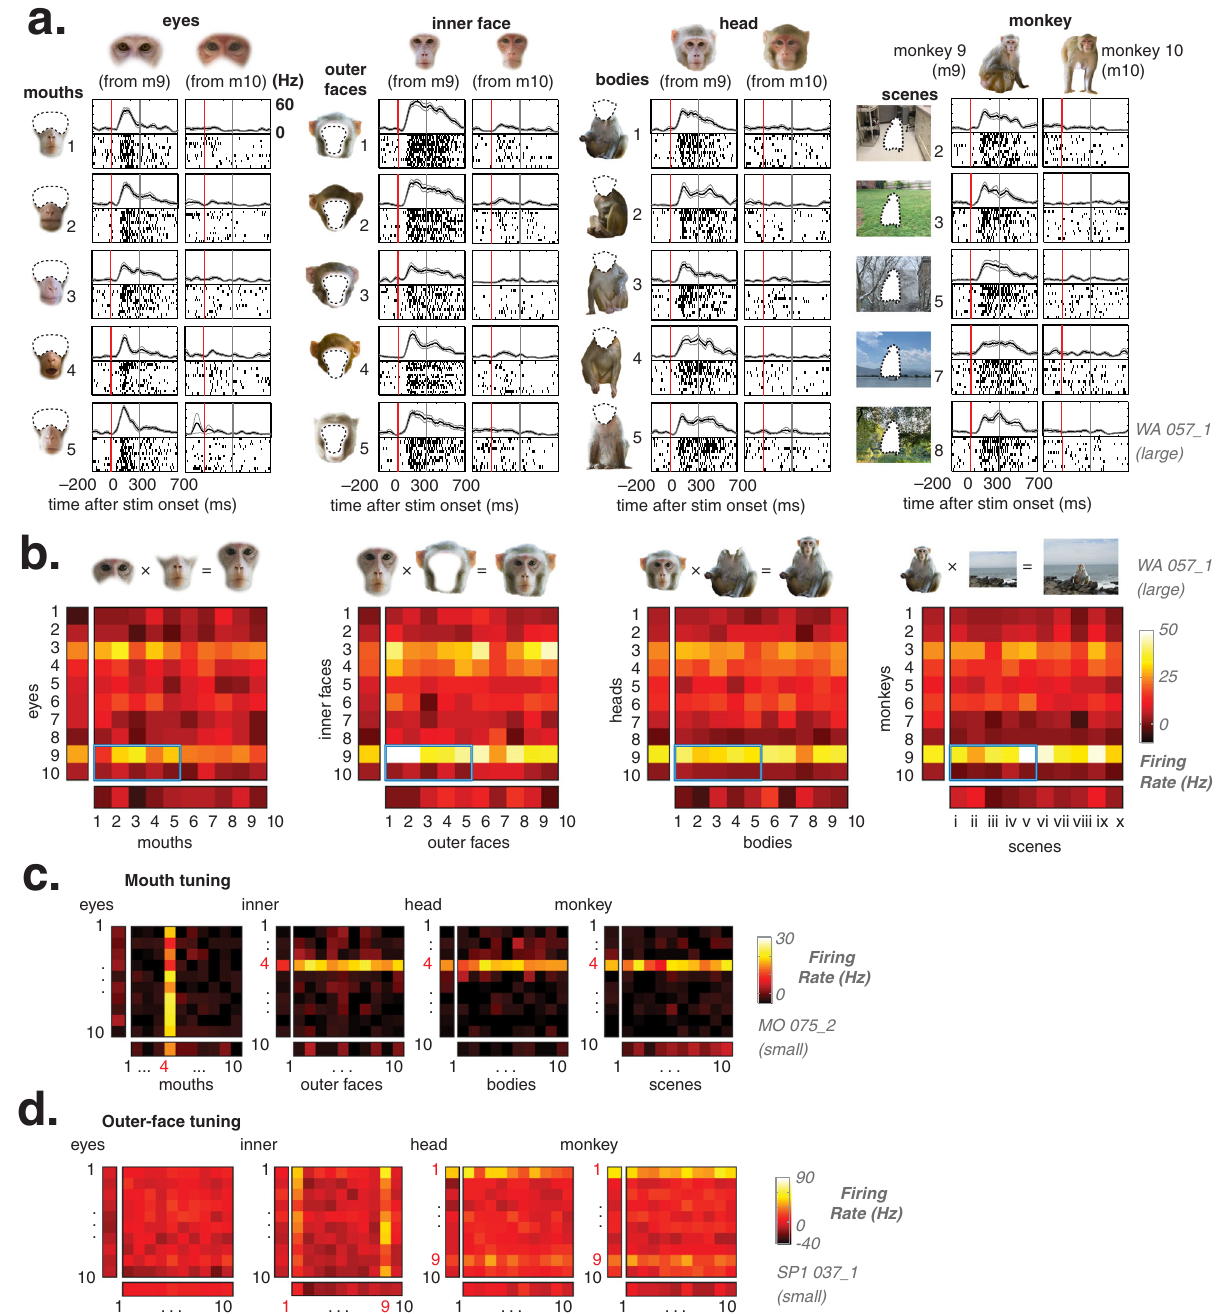
Fig. 2 | Individual face-selective neurons show strong tuning to single local facialparts.a RasterplotsshowingresponseofonetypicalAMneuron(WA-057_1). From left column: response to eyes × mouth stimuli (eyes from monkeys 9 and 10, recombined with mouths from monkeys 1 to 5. Subsequent columns: responses to inner × outer face , head × body , and monkey × scene stimuli from monkeys 9 to 10. b HeatmapsofAMneuronWA-057_1average fi ringrateinresponsetolargestimuli of all swapping categories; responses to combined stimuli in central square